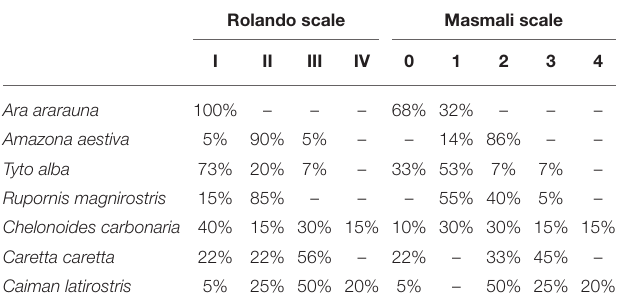
TABLE 3 | Frequencies of tear ferning test grading (TFT) of birds and reptiles using Rolando and Masmali scales.